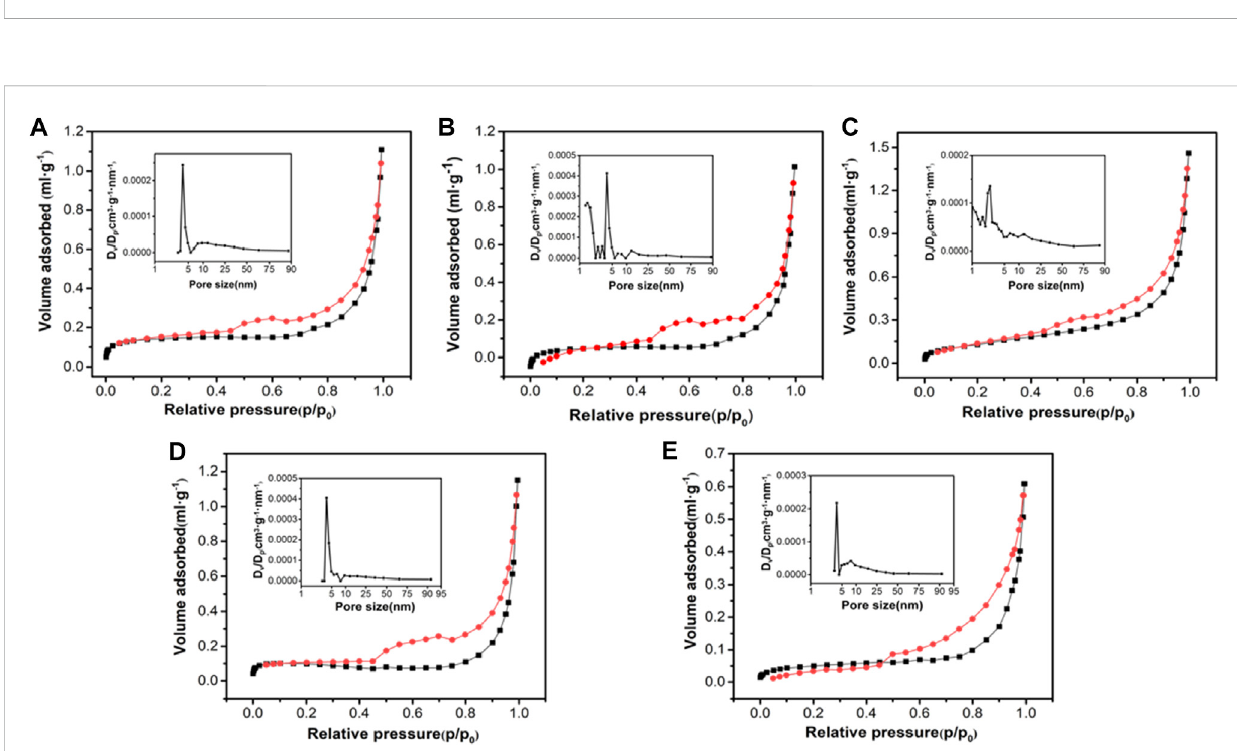
FIGURE 3 N 2 adsorption-desorption isotherms and pore size distribution curves of Mag-25 (A) , Mag-300 (B) , Mag-500 (C) , Mag-700 (D) , and Mag-900 (E) .